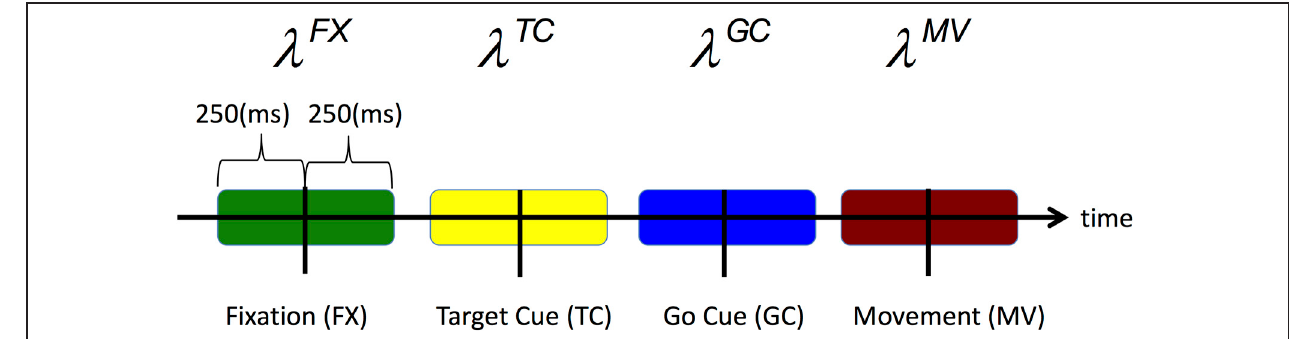
FIGURE 2 | Time periods over which the CIF denoted by Equation (3), is estimated are